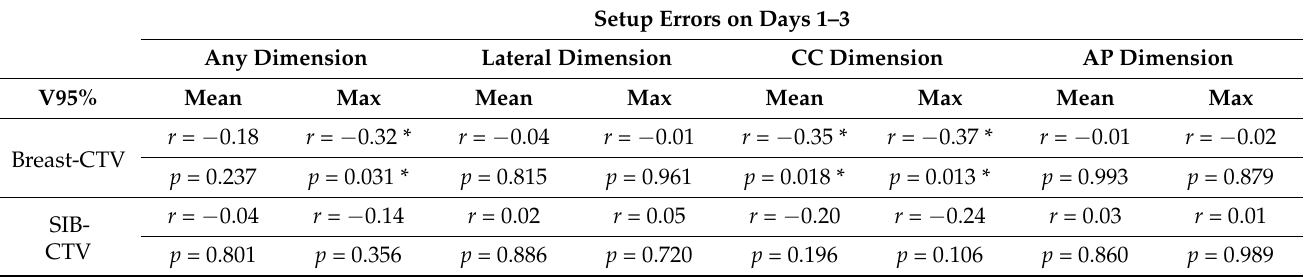
Figure 4. Relation between breast-CTV ( a ) and SIB-CTV ( b ) coverage and (mean and maximum) setup errors in any dimension. *statistically significant ( p < 0.05). Table 1. Correlation analysis for CTV coverage and setup errors on days